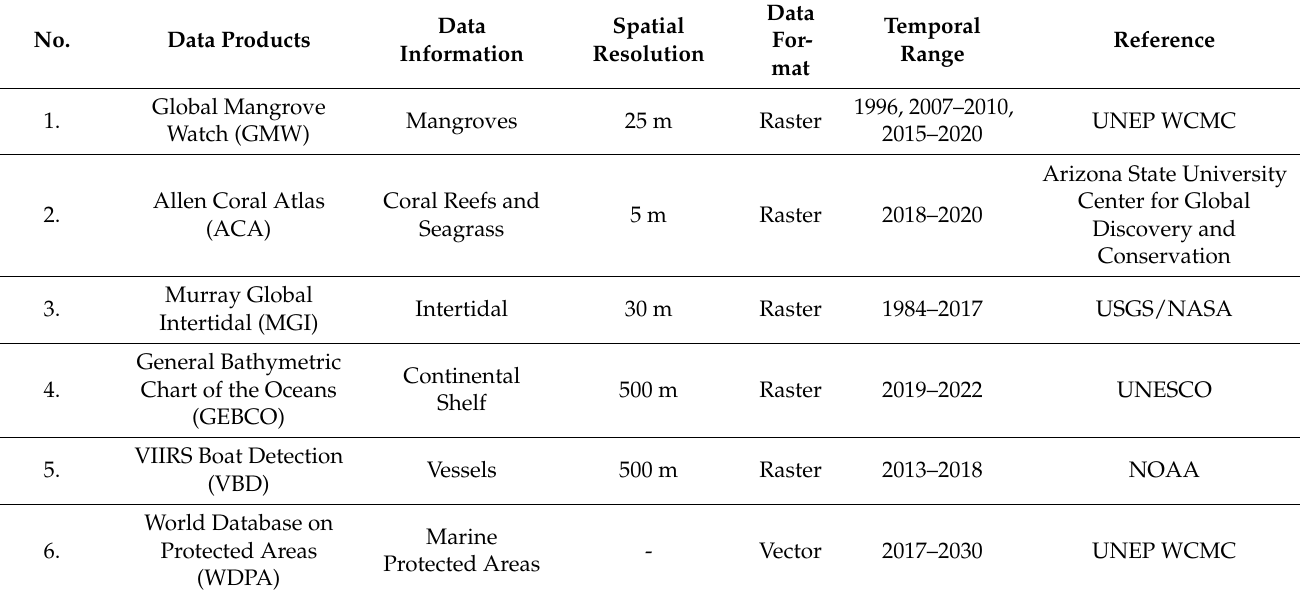
Table 2. Specification of data products used in this